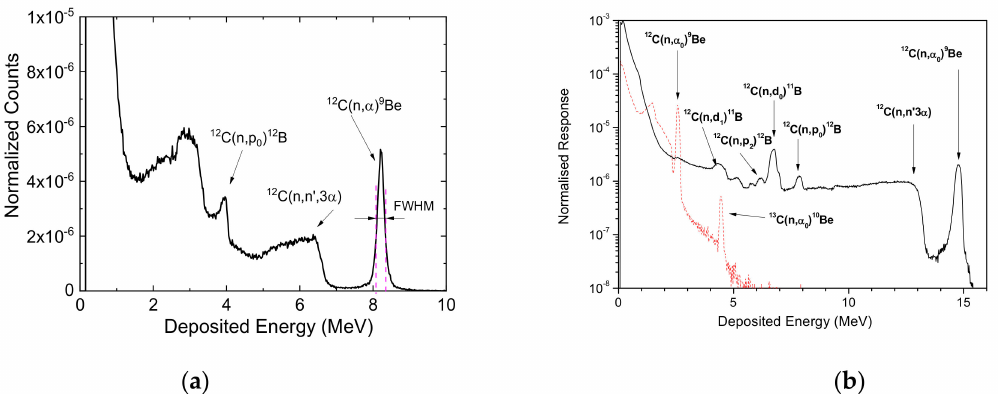
Figure 15. ( a ) Pulse height spectrum (PHS) recorded with a 500 µ m thick diamond detector irradiated by 13.8 MeV neutrons. The main reactions are indicated; ( b ) PHS recorded with a diamond detector irradiated with 8.3 MeV (red-dashed) and 20.5 MeV neutrons (black-continuous). Let us note the many peaks emerge in the PHS recorded using 20.5 MeV neutrons and due to the new reaction channels opening for E n > 15